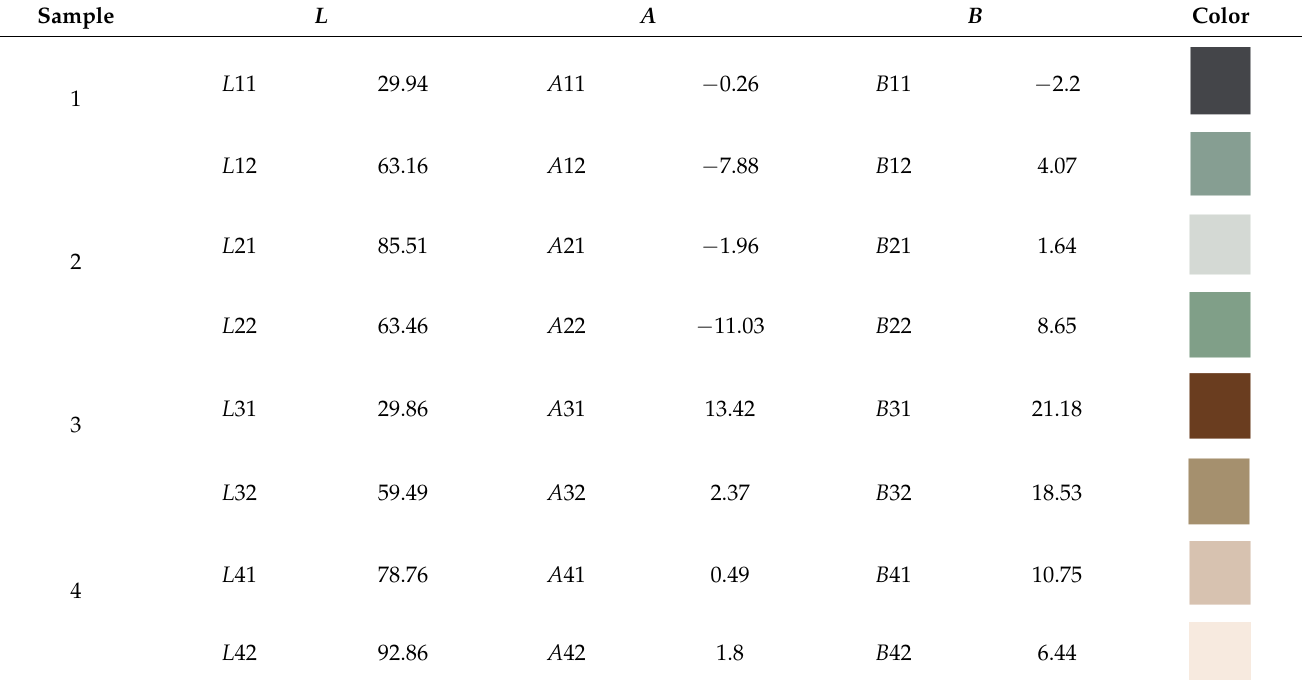
Table 2. Ceramic glaze sample color information table.